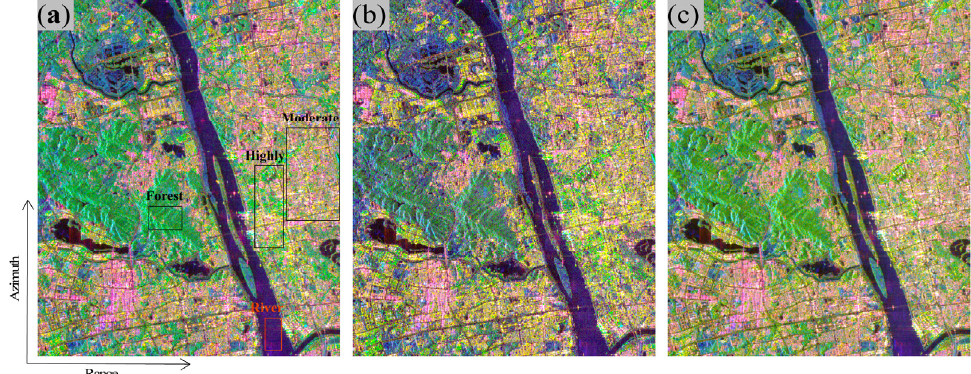
Figure 3. The color-coded images of the decomposition results for the ALOS- 2/PALSAR-2 dataset (red: double-bounce; green: volume scattering; blue: surface scattering). ( a ) X5D decomposition method. ( b ) 7SD decomposition method. ( c ) Proposed decomposition method.